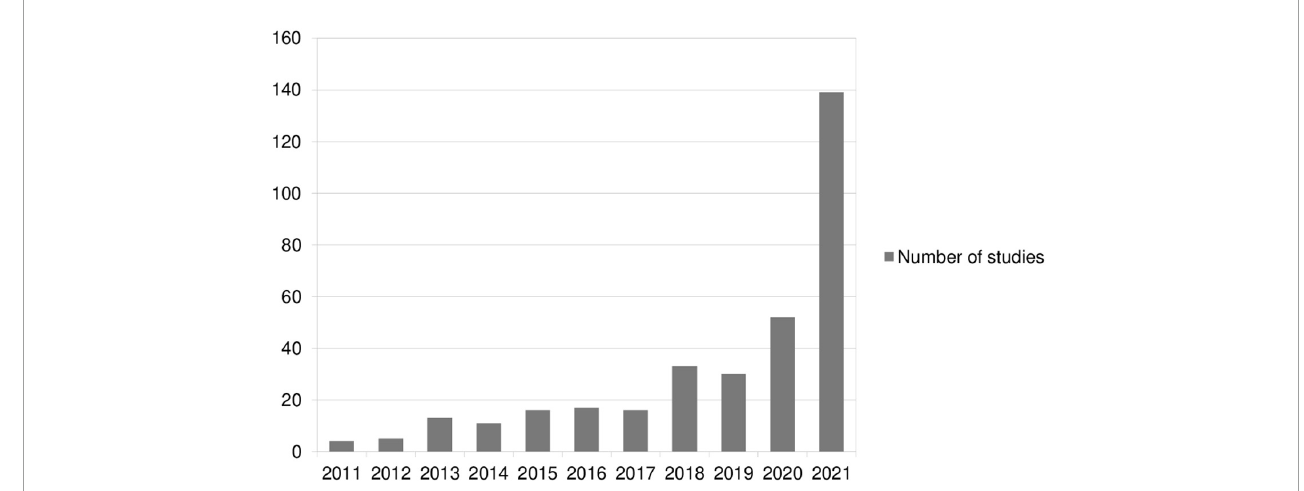
FIGURE2 Number of studies on conspiracy beliefs per year based on Goreis and Voracek (2019) and the current